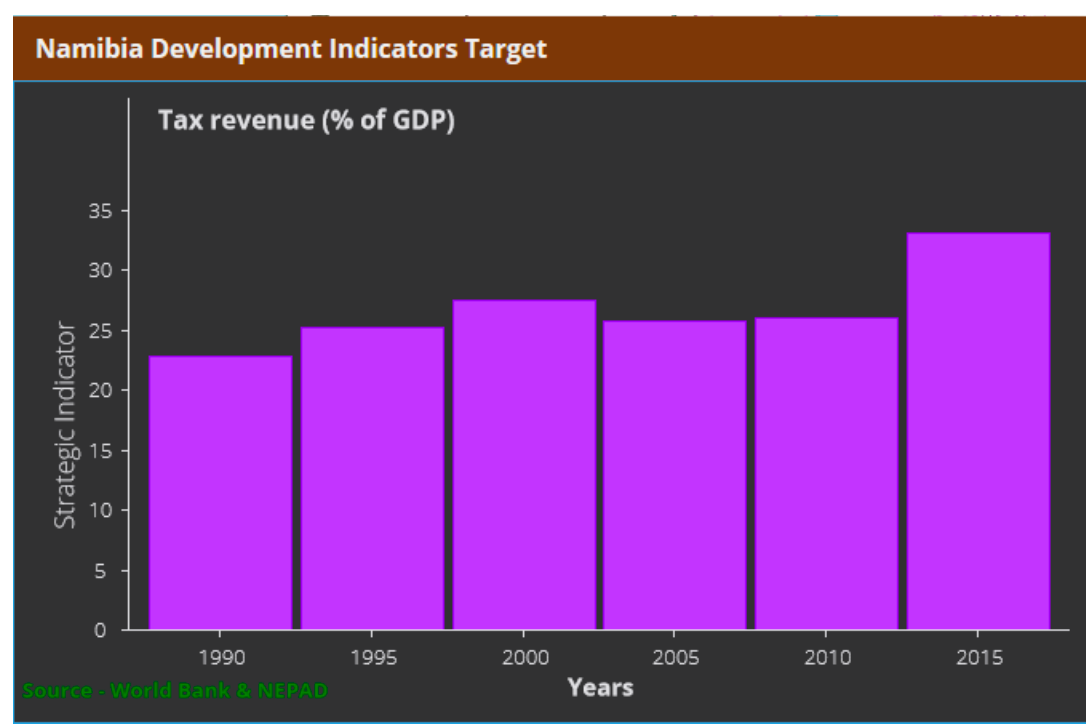
Figure 16. Tax revenue information displayed by the front end.